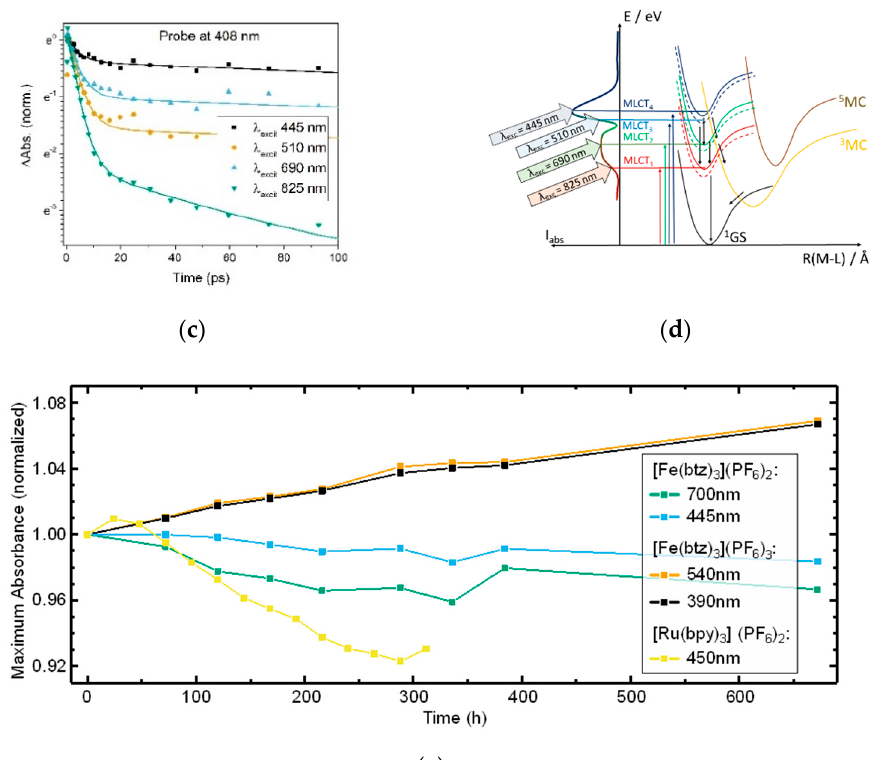
Figure 11. Band-selective photophysics of complex 25 (II), investigated by Chábera et al. [76]. ( a ) Steady-state spectra of complex 25 in oxidation states II and III in acetonitrile. The red arrows indicate the excitation wavelengths for transient absorption experiments. ( b ) Transient absorption spectra of complex 25 (II) recorded 1 ps after excitation, normalized by the number of absorbed photons per cm 2 at each respective excitation wavelength ( λ excit ). The x -axis (wavelength) is in reciprocal values (linear steps in energy. ( c ) Comparison of complex 25 (II) kinetics following excitations at di ff erent wavelengths (see legend) for kinetics recorded at 408 nm. Note that the graph shown in c) is plotted in ∆ A (ln) / Time (lin) scale. The kinetics have been normalized for visual clarity and the solid lines represent the fits. ( d ) Excited state manifold in the charge-transfer excitation energy region for complex 25 (II), indicating the di ff erent excitation energies / wavelengths employed experimentally to probe the excited state dynamics (red, green, light blue and blue arrows), as well as selected potential decay paths (black arrows). Singlet and triplet forms of representative MLCT states in the charge-transfer manifold energy region are distinguished as solid and dashed lines, respectively. ( e ) Long-term photostability of 25 (II) and 25 (III). Minor deviations from initial maximum absorption ( < 10% after 600 h continuous irradiation), associated with minor degradation and / or solvent evaporation. Results in a – d adapted with permission from ref [76], published by The Royal Society of